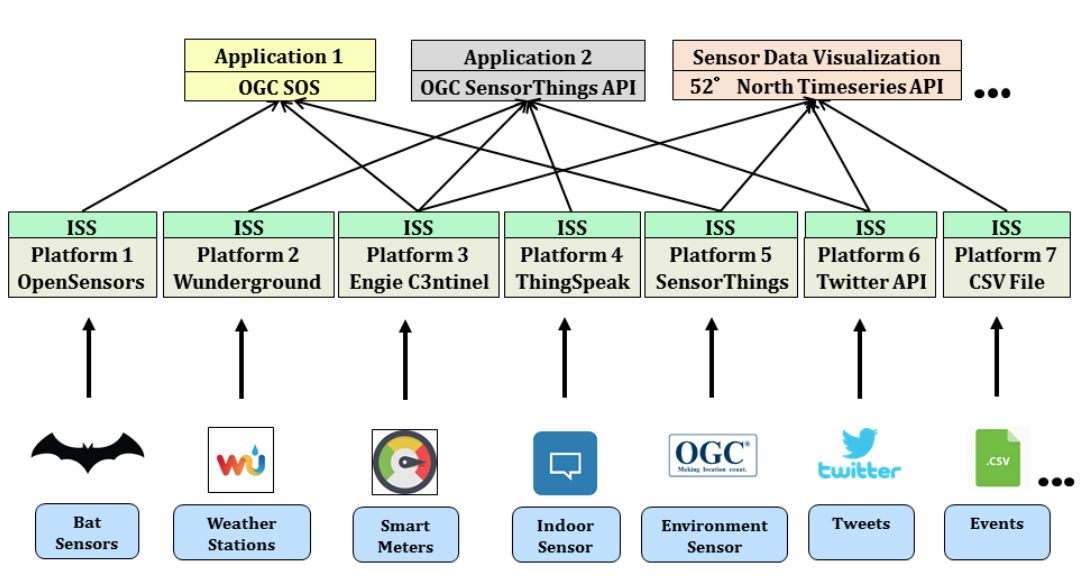
Figure 6. Implementation scenario of the InterSensor Service (ISS) establishing interoperability for different sensor platforms and observations in the district Queen Elizabeth Olympic Park,